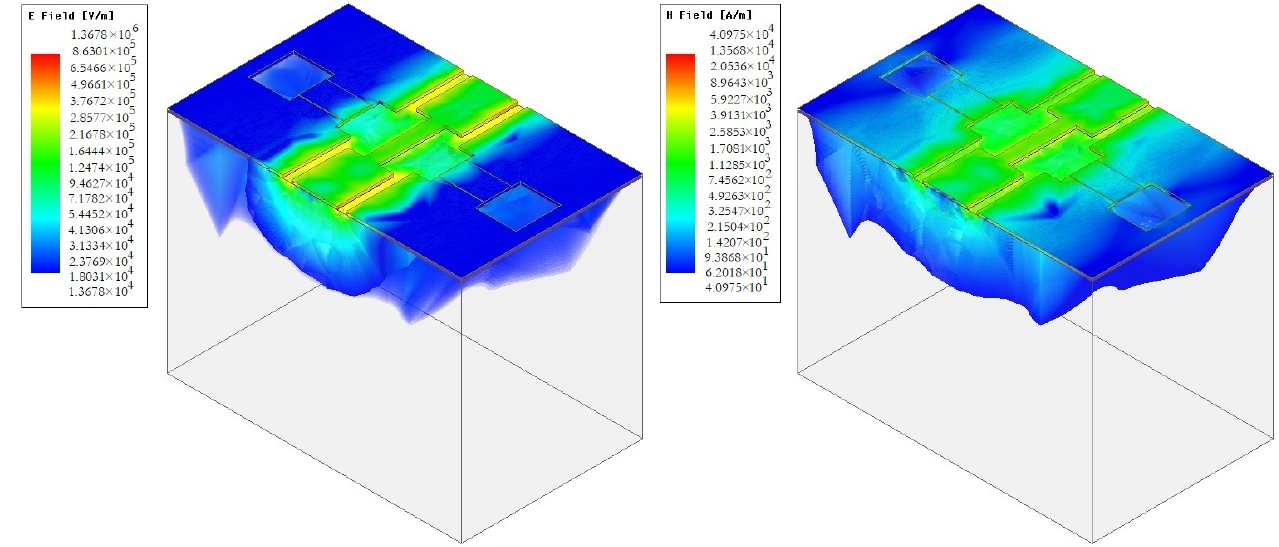
Figure 8. The distribution of E and H fields in the developed design of CPW (A).